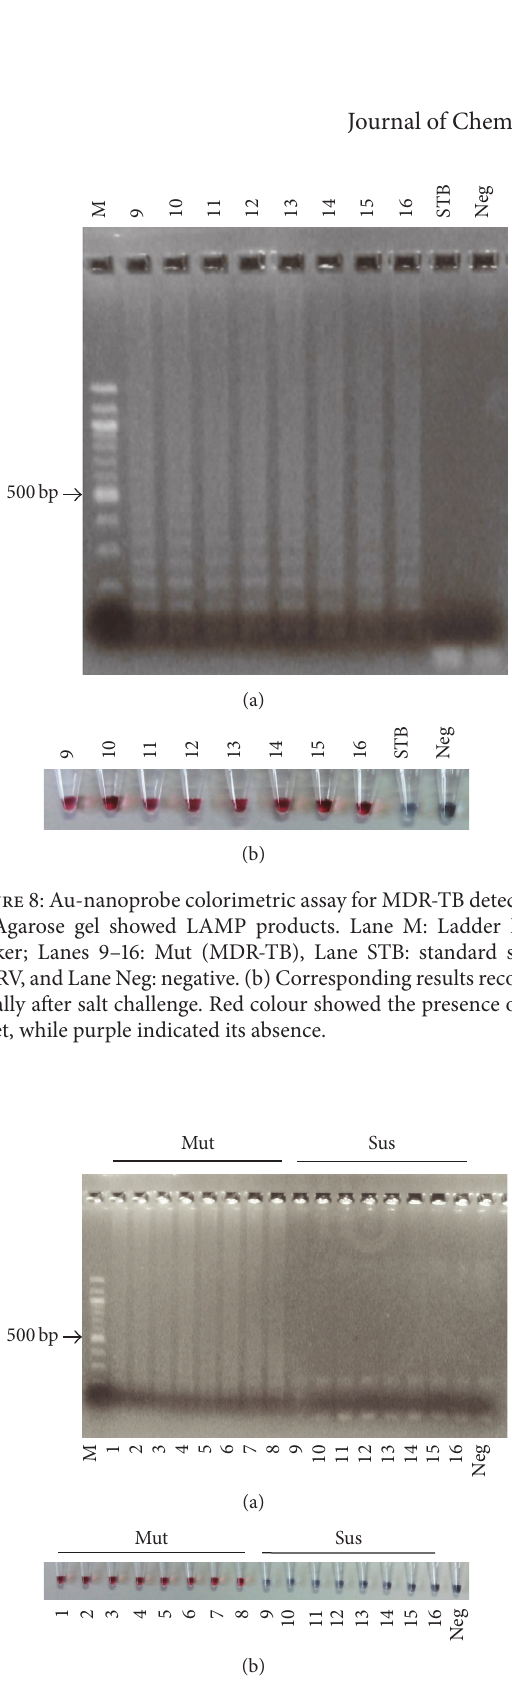
Figure 9: Detection of MDR-TB members via Au-nanoprobe assay. (a) Agarose gel showed LAMP products. Lane 1 (M): Ladder DNA marker; Lanes 1–16: Mut as MDR-TB, Sus as INH susceptible, and Neg as negative. (b) Corresponding results recorded visually after salt challenge. Red colour showed the presence of the target, while purple indicated its